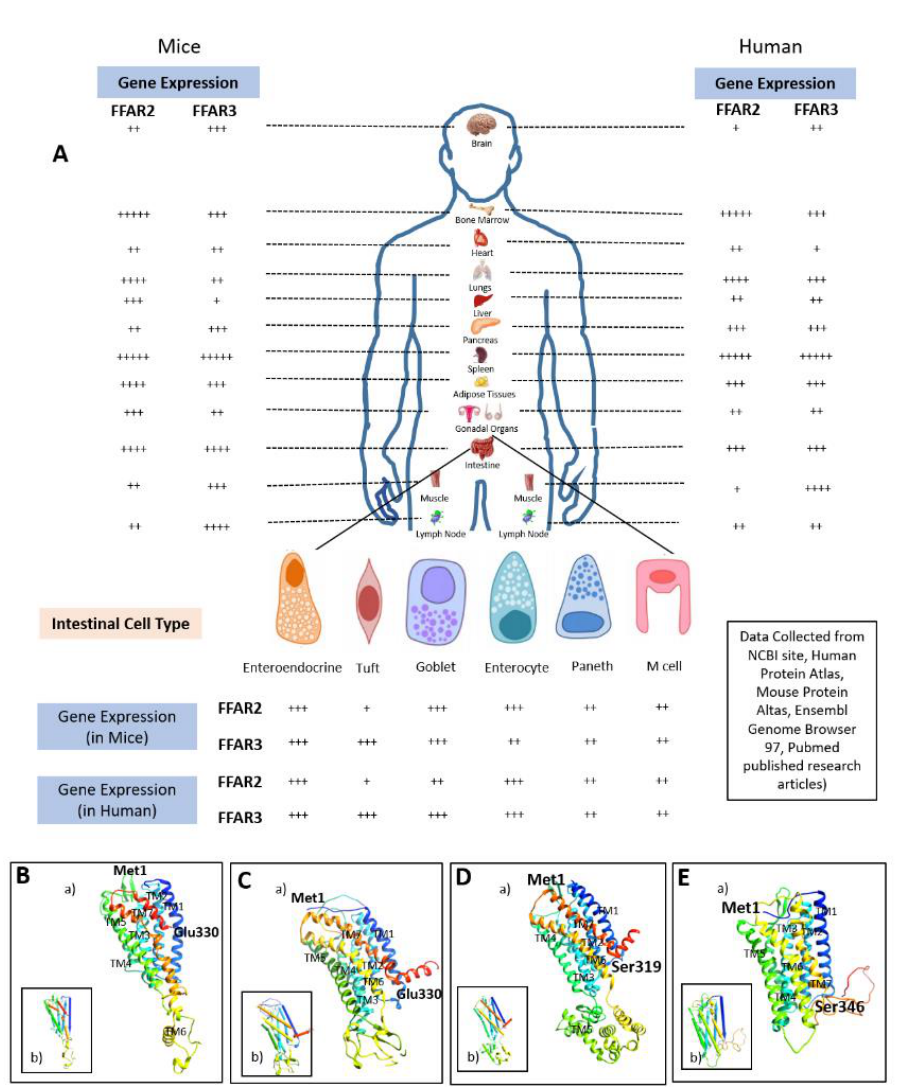
Figure 2. ( A ) Diagrammatic representation of FFAR2 and FFAR3 expression in human tissues / cells and their comparison with mouse tissues / cells. ( B – E ) Homolgy structure of mouse ( B , D ) and human ( C , E ) FFAR2 ( A , B ) and pFFAR3 ( D , E ) protein. (a,b) Depicts the rainbow (a) and pipes and plank (b) structures.